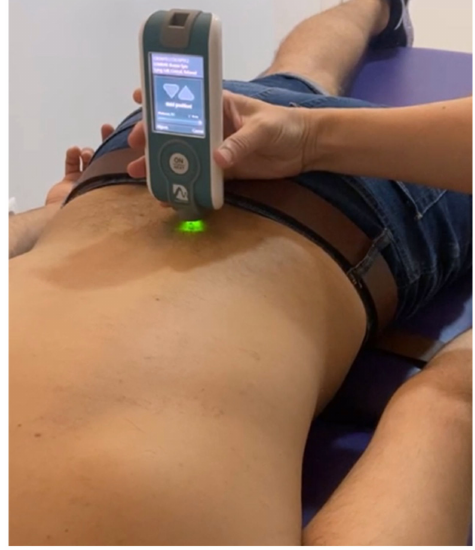
Figure 1. Procedure for measuring MMPs at lumbar level with